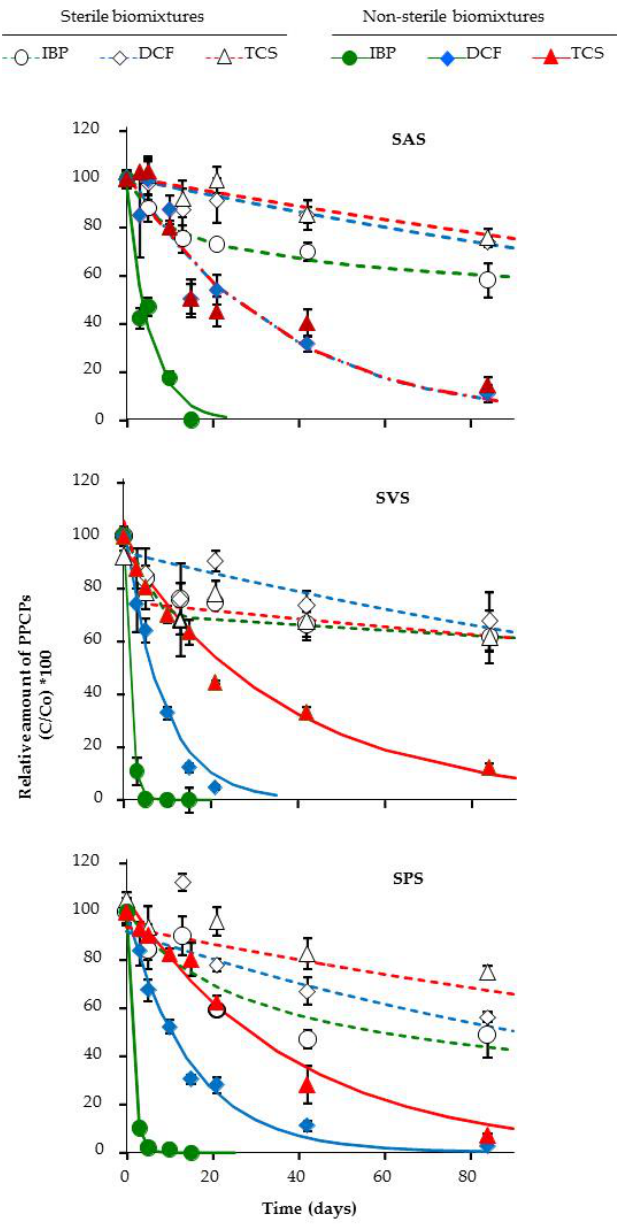
Figure 1. Degradation of ibuprofen, diclofenac and triclosan in non-sterilized and sterilized biopurification systems consisting of biomixtures of soil, wet olive cake or alperujo and barley straw (SAS), soil, vermicompost and barley straw (SVS) and soil, peat and barley straw (SPS). Symbols and lines represent the experimental data and the fit to the single first order kinetic model, respectively. Error bars indicate the standard deviation (n = 3).